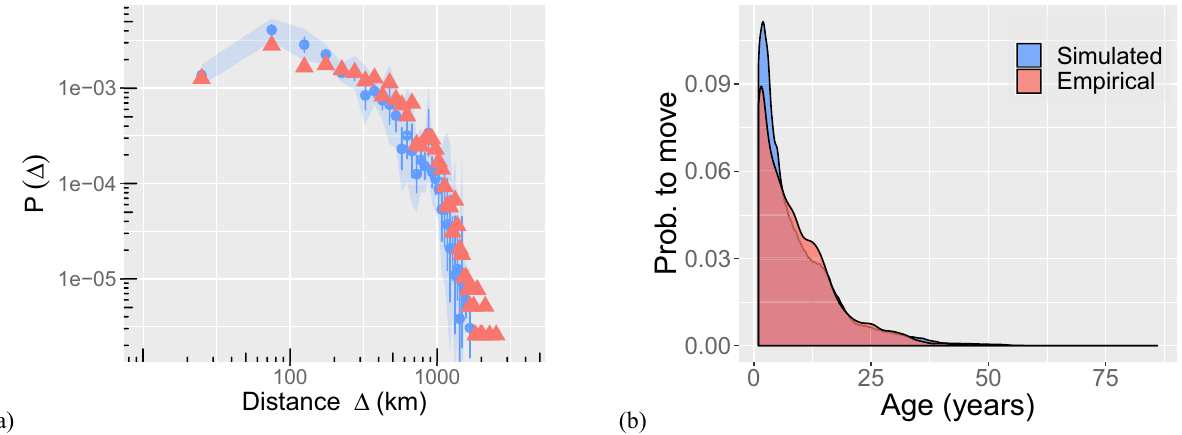
Figure 4. Comparison of simulated and empirical individual scientist features. ( a ) Distribution of relocation distances of scientists. ( b ) Distribution of moves dependent on the (academic) age of scientists, (red) indicates the empirical distribution, (blue) the distributions that are obtained from our agent-based